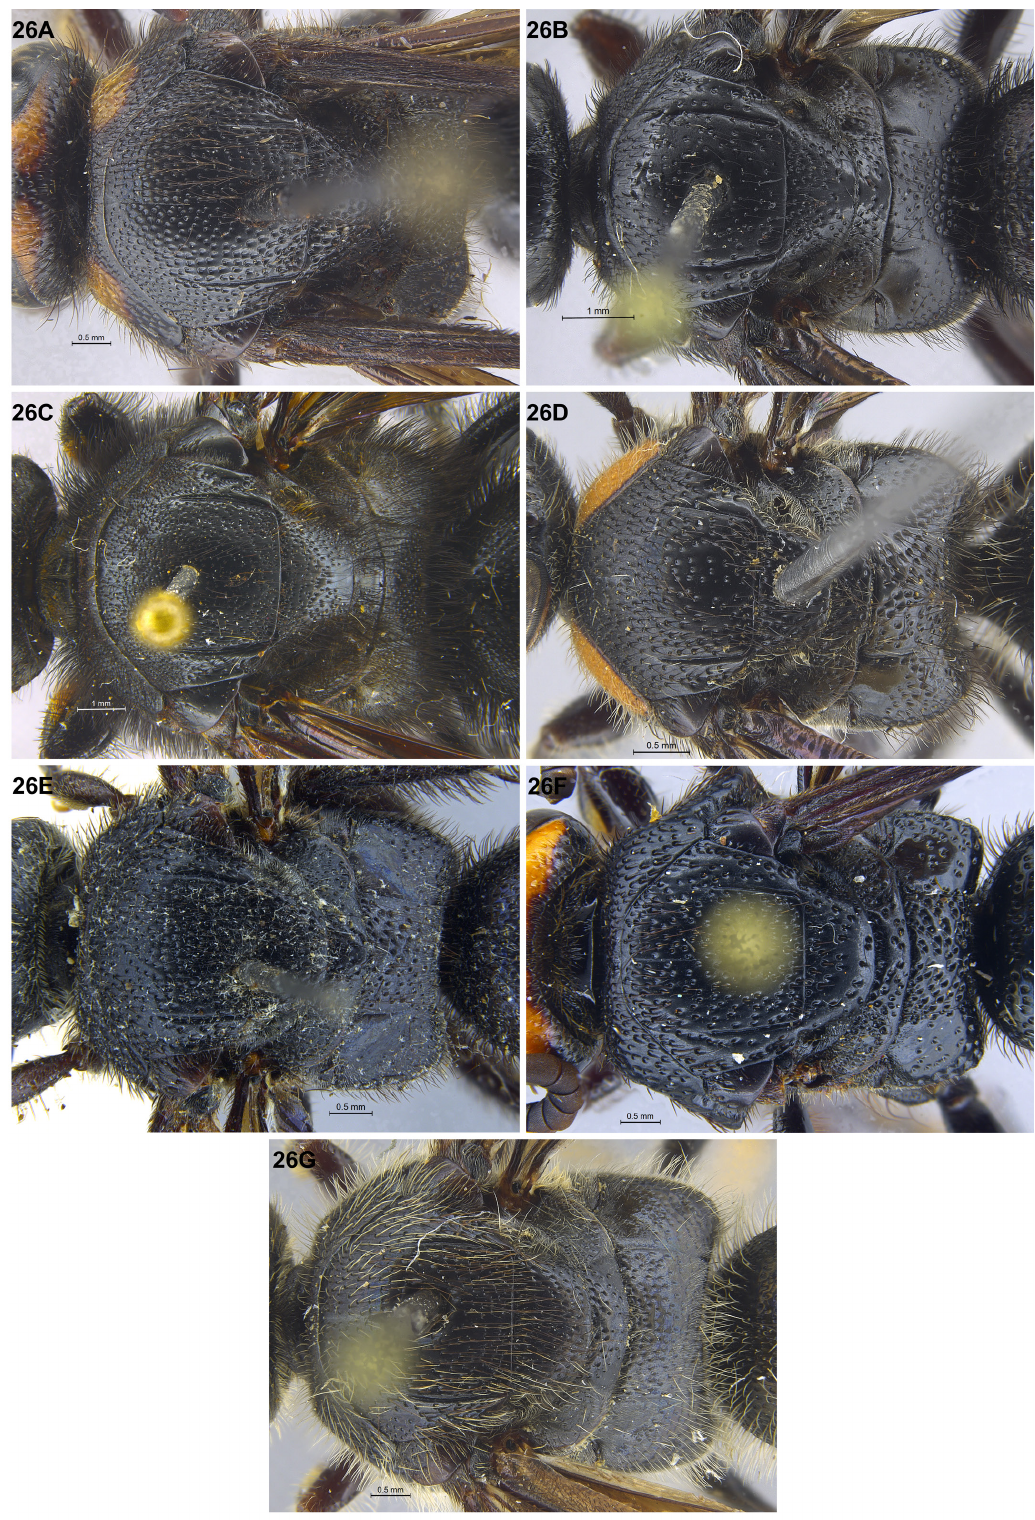
Fig. 26. Males, mesoscutum. A . Carinoscolia junnanensis . B . Liacos erythrosoma (Burmeister, 1854). C . Megascolia azurea (Christ, 1791). D . Scolia binotata Fabricius, 1804. E . Sc. laeviceps Smith, 1855. F . Sc. pakshaoensis sp. nov., paratype (CBC). G . Sc . superciliaris de Saussure & Sichel, 1864